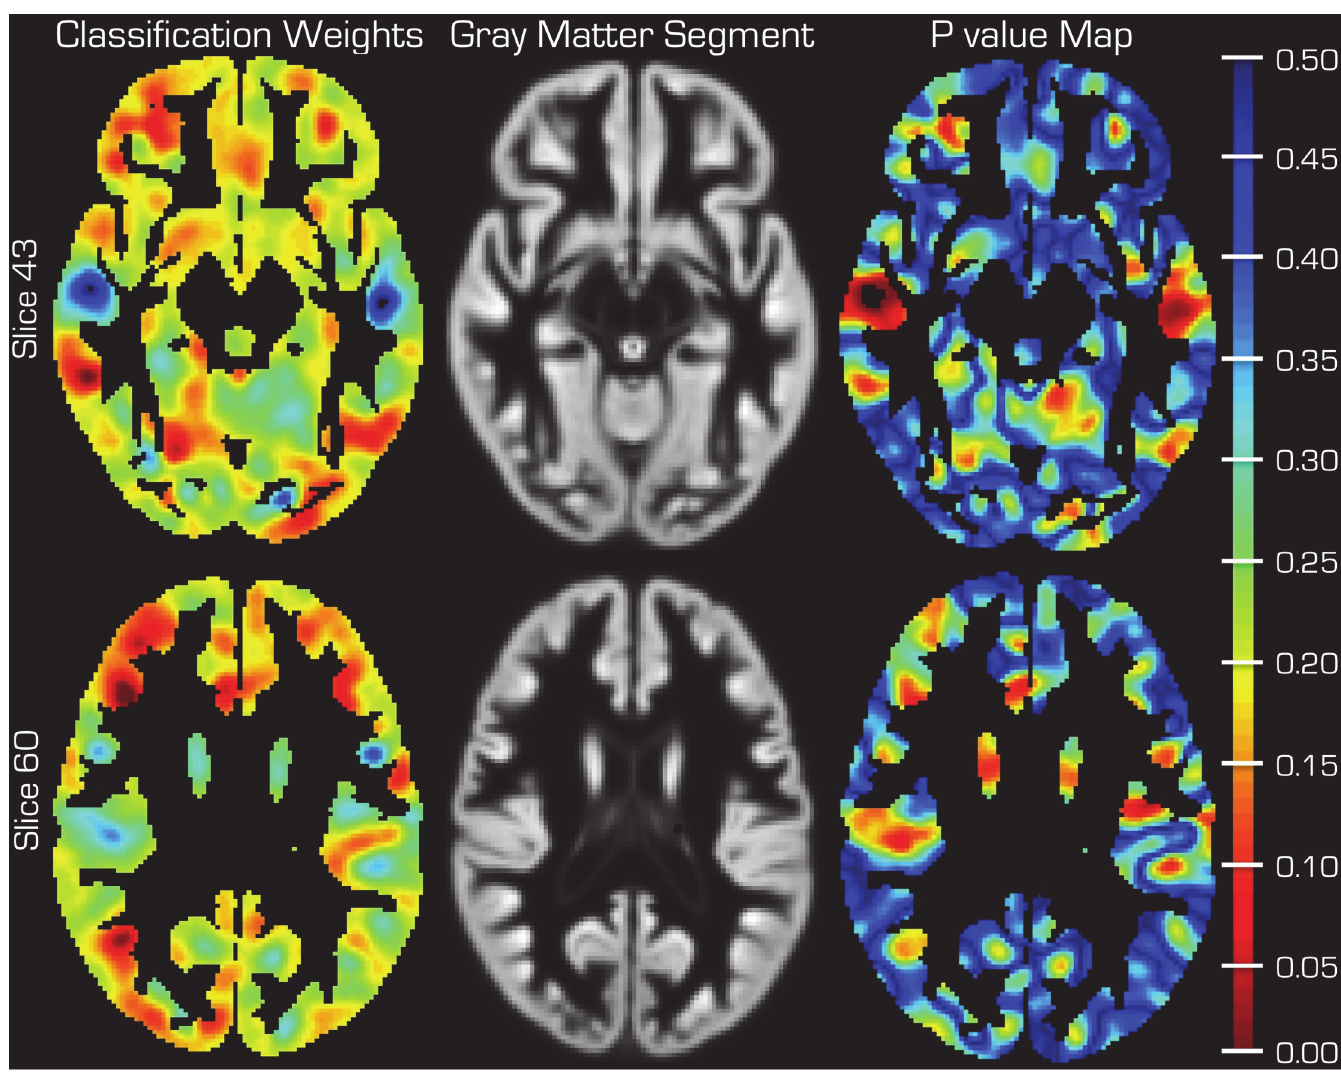
Fig 2. Gray Matter segment discriminative power for classification and p value map. Mean gray matter segment of all subjects is shown in the middle column for anatomical orientation. The color code on the images of the left column is in arbitrary units and indicates the weight (i.e. discriminative power ) in each voxel. This value in each voxel is relative to the weight in all other voxels containing brain GM. The plots in the right column depict the corresponding p value maps. The color bar on the far right belongs only to the p value maps.